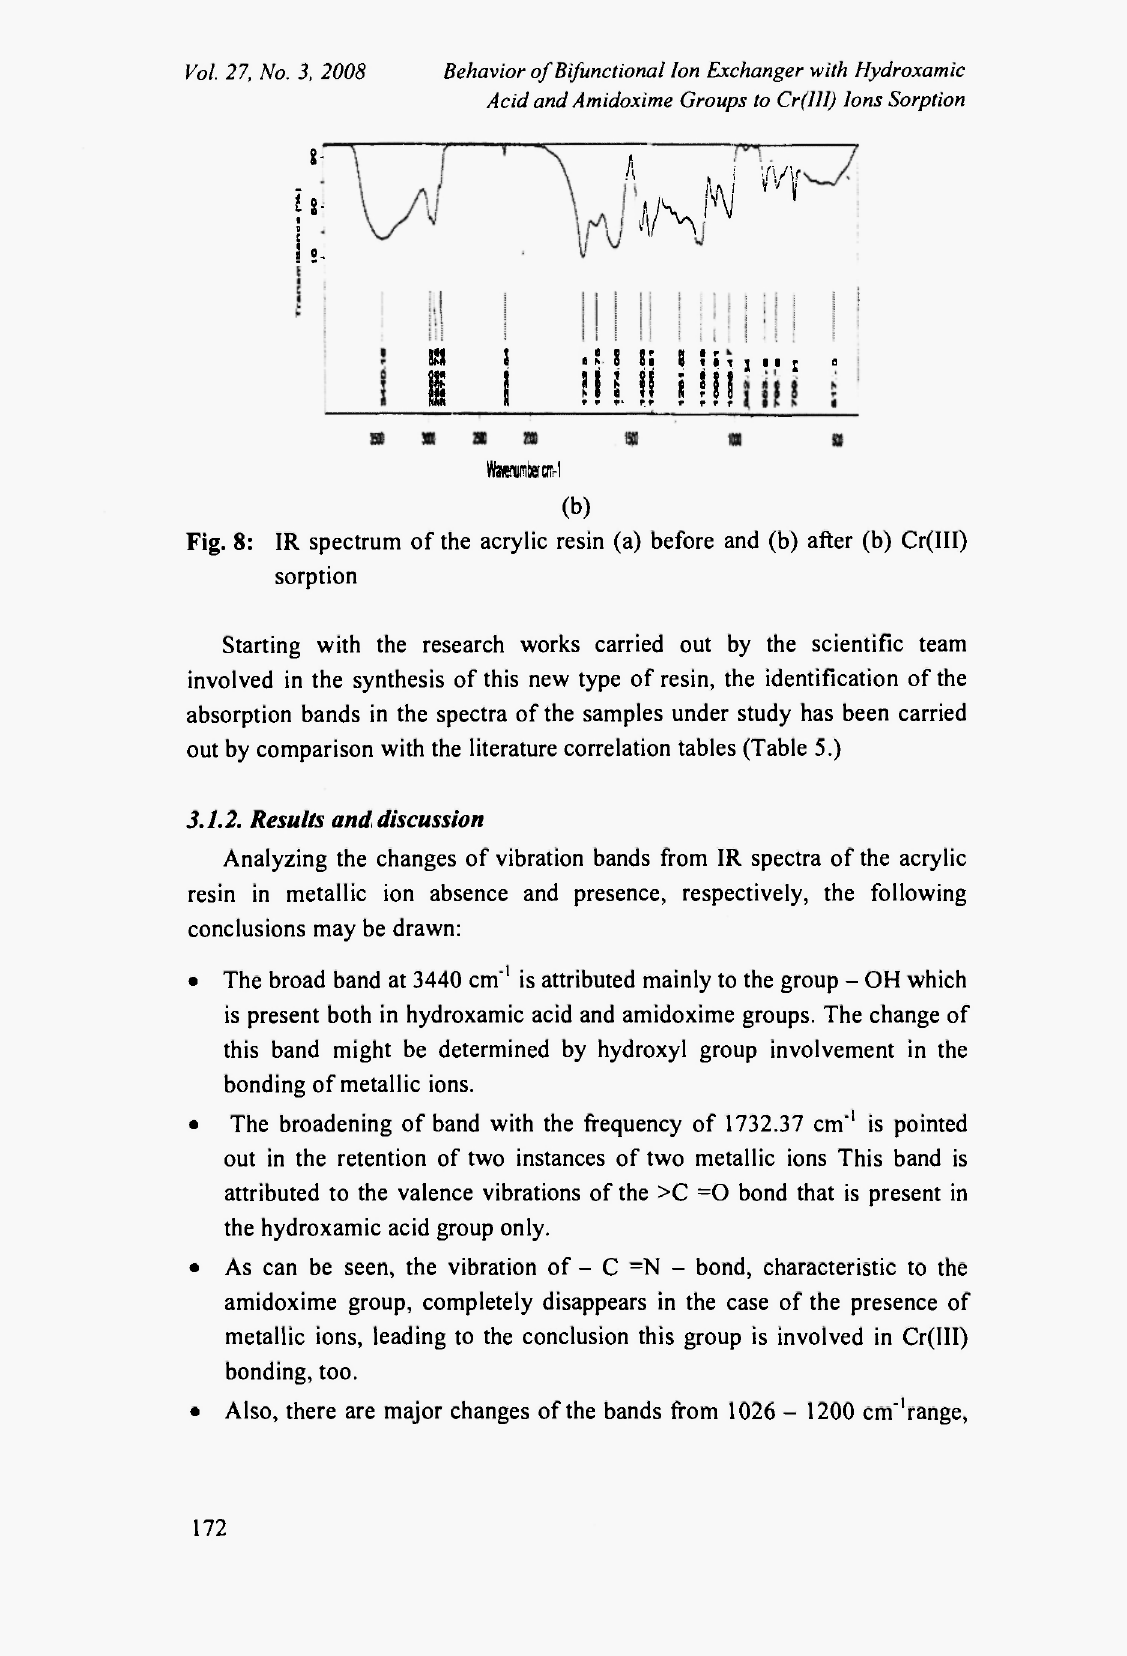
Fig. 8: IR spectrum of the acrylic resin (a) before and (b) after (b) Cr(III)